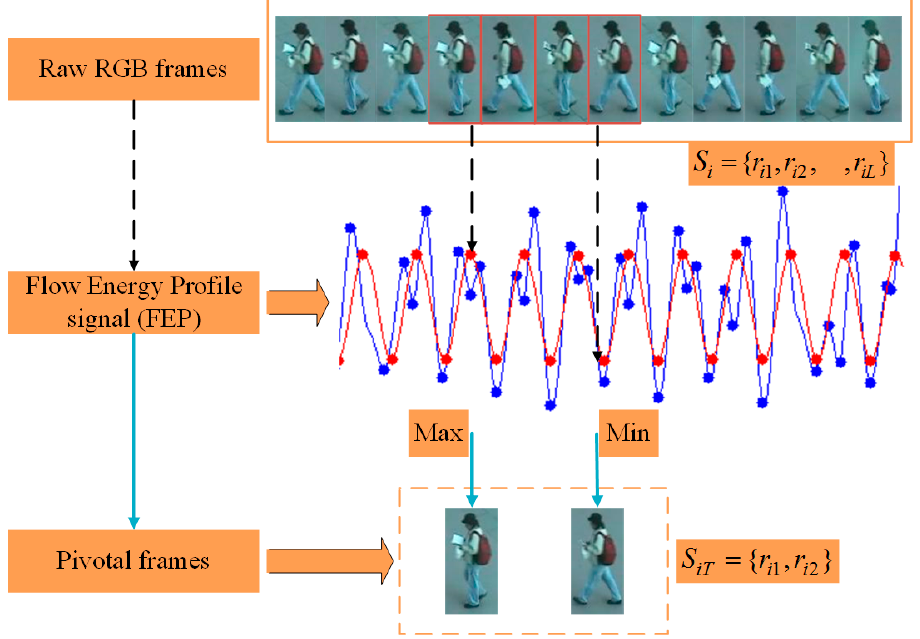
Figure 4. Pivotal frames extraction. The image frames with the golden box in the raw RGB frames is a partially selected video segment. The red curve in the Flow Energy Profile (FEP) signal is the regular FEP value and the blue curve is the rough FEP value.